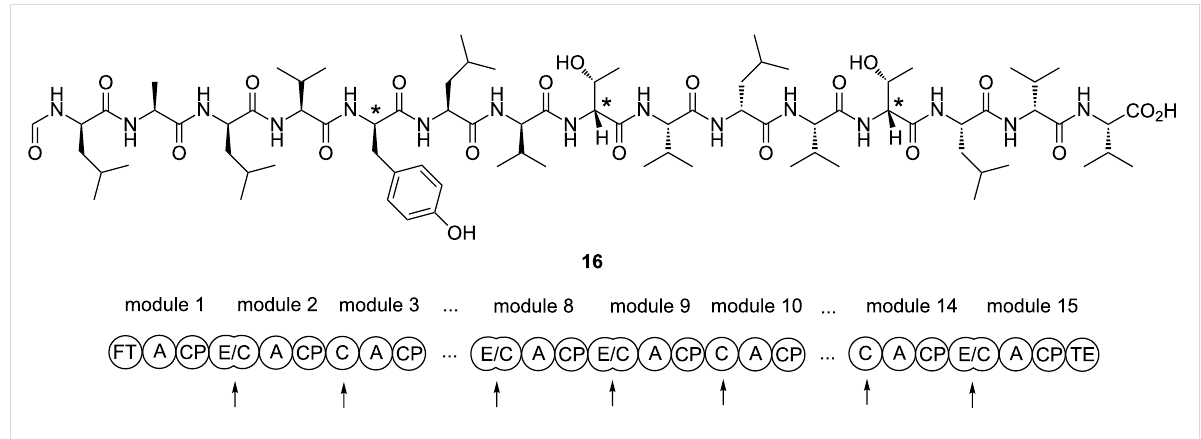
Figure 4: Top: Structure of the NRPS product kollosin A ( 16 ) with the sequence N -formyl-D-Leu-L-Ala-D-Leu-L-Val-D-Tyr-L-Leu-D-Val-D-aThr-L-Val- D-Leu-L-Val-D-aThr-L-Leu-D-Val-L-Val-OH (aThr: allo -threonine). Bottom: Domains of some of the 15 modules (FT: formyltransferase, A: adenylation, CP: peptidyl carrier protein, C: condensation, E/C: condensation + epimerization, TE: thioesterase). For the absolute configuration of incorporated amino acids relevant domains are highlighted with arrows. Modules not shown consist of alternating C and E/C. Asterisks indicate stereocenters deduced from labeling